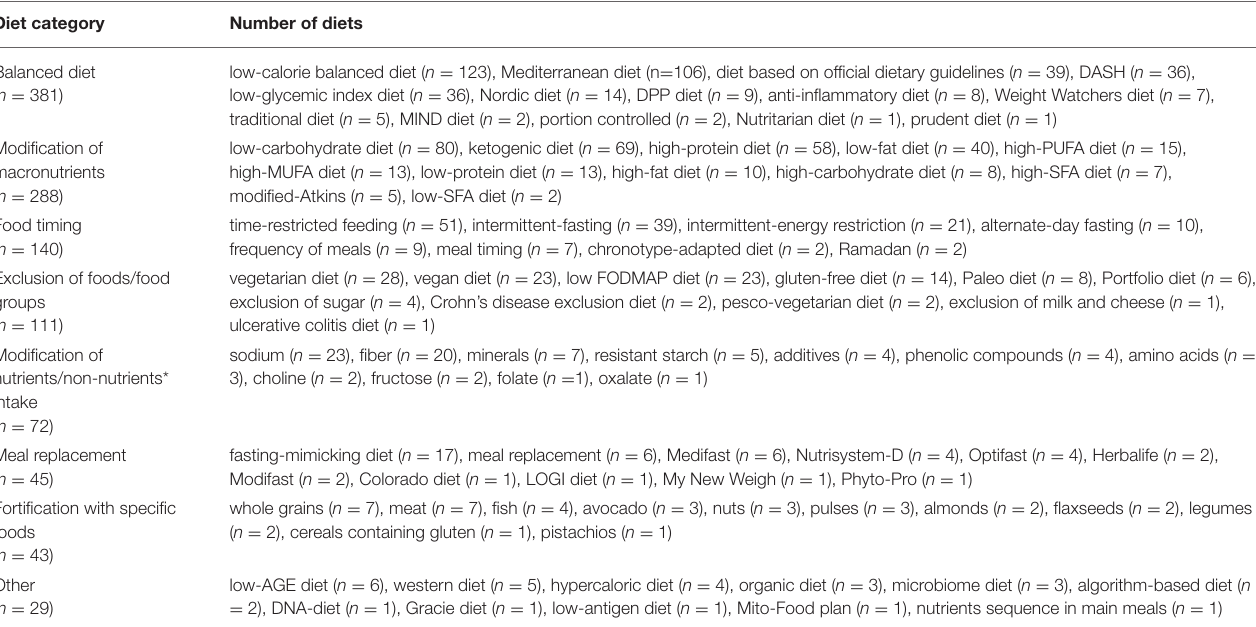
TABLE 1 | Diets object of study in health-related trials registered on ClinicalTrials.gov from 2010 to 2020. Diet